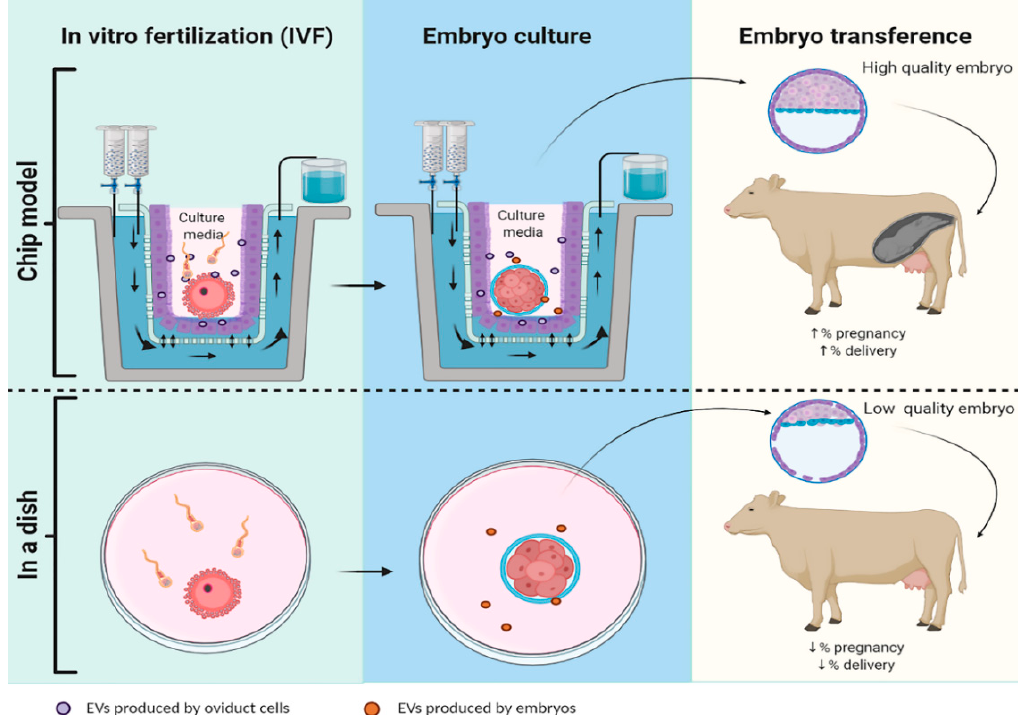
Figure 2. Schematic representation of embryo production using a Chip-model or an in vitro model (in a dish). Hypothetically in a Chip-model, the system mimics estrus cycle hormones concentrations that allows oviductal cells to develop cilia and produce EVs that will vary their cargo along the estrus cycle, increasing the pregnancy and delivery rate. In contrast, in embryo production by classic ART in a dish there is no interaction with EVs oviduct, consequently the embryos produced have lower quality and less chance of implantation and ending in delivery.